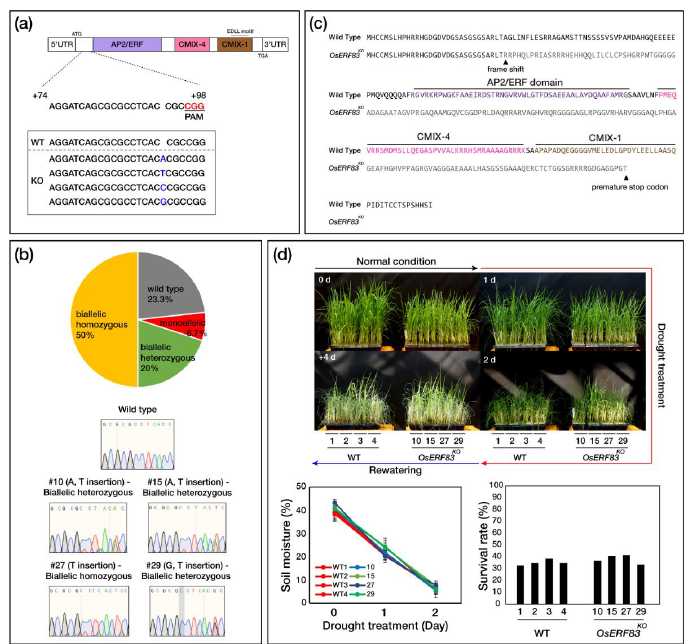
Figure 4. Construction of knock-out ( OsERF83 KO ) mutants and their phenotypes. ( a ) Schematic illustration of the target sites in the OsERF83 genomic sequence. The protospacer adjacent motif (PAM) sequence is marked in red. Mutation sequences are marked in blue. ( b ) Mutation pattern on OsERF83 KO #10, #15, #27, and #29 plants. ( c ) Amino acid sequence alignment of OsERF83KO plants revealed a frameshift and premature stop codon. ( d ) Phenotypes of OsERF83 KO (#10, #15, #27, #29) and WT plants under drought stress. All plants were grown in soil for 5 weeks under well-watered conditions, exposed to drought stress for 2 days, and then rewatered for 4 days, in the greenhouse. Measurement of the soil moisture contents (%). The data represent the mean value ± SD of five measurements performed at different locations in the soil. The survival rate of transgenic plants was scored 4 days after rewatering.